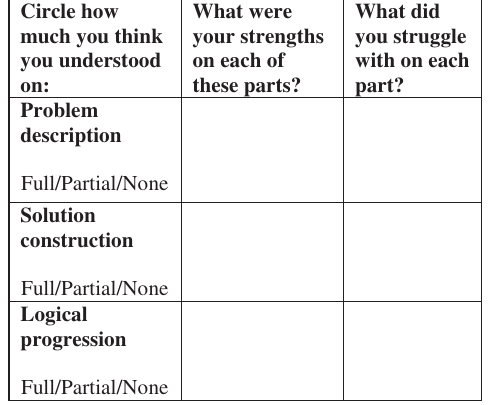
FIG. 2. Rubric used by students for metacognition, in consid- eration of a generalized problem-solving